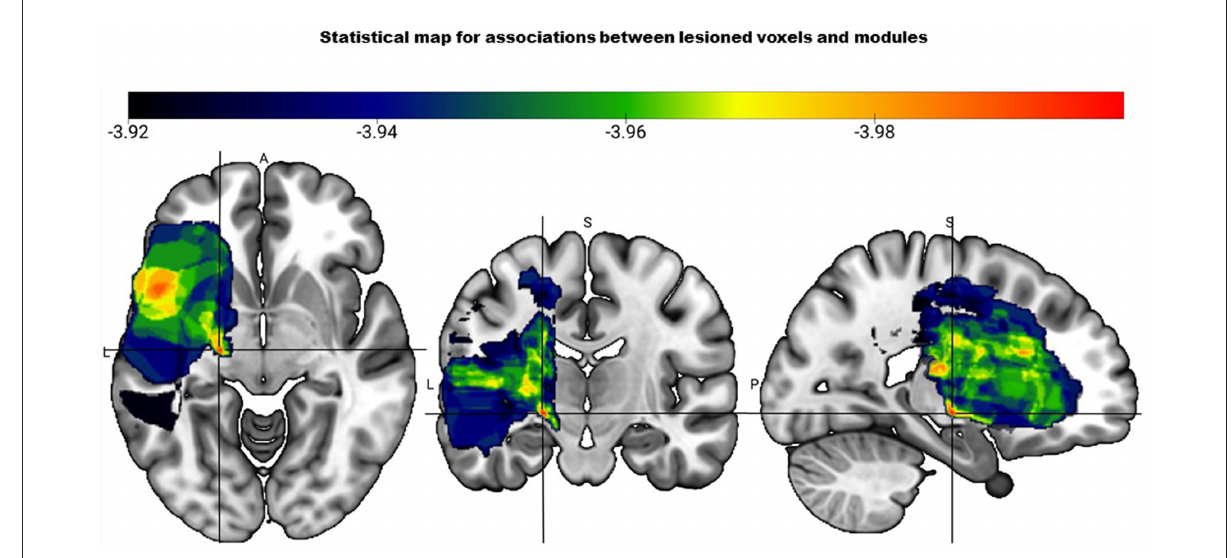
FIGURE2 Statistical map based on the voxel-based lesion mapping analysis shows the association between number of modules and lesioned voxels. Color scale indicates strength of association between two module pattern and lesion location with red having the strongest association (represented by the crosshair).